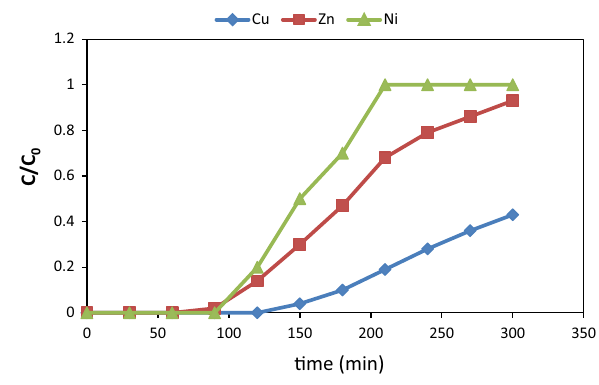
Fig. 6 Breakthrough curve for the adsorption copper, nickel and zinc on VAS-I (flow rate = 1.4 ml/min; T = 27 ± 1